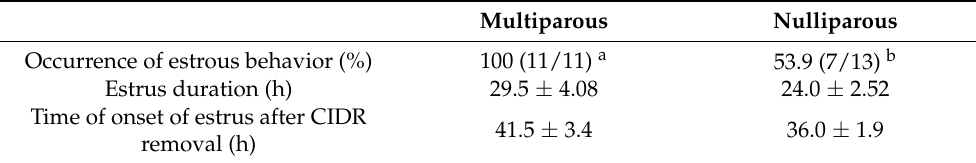
Table 1. Percentage and timing ( ± S.E.M.) of occurrence of estrus in multiparous and nulliparous ewes after a short-term treatment with a controlled internal drug release (CIDR) and equine chorionic gonadotrophin (eCG) during seasonal anestrus.